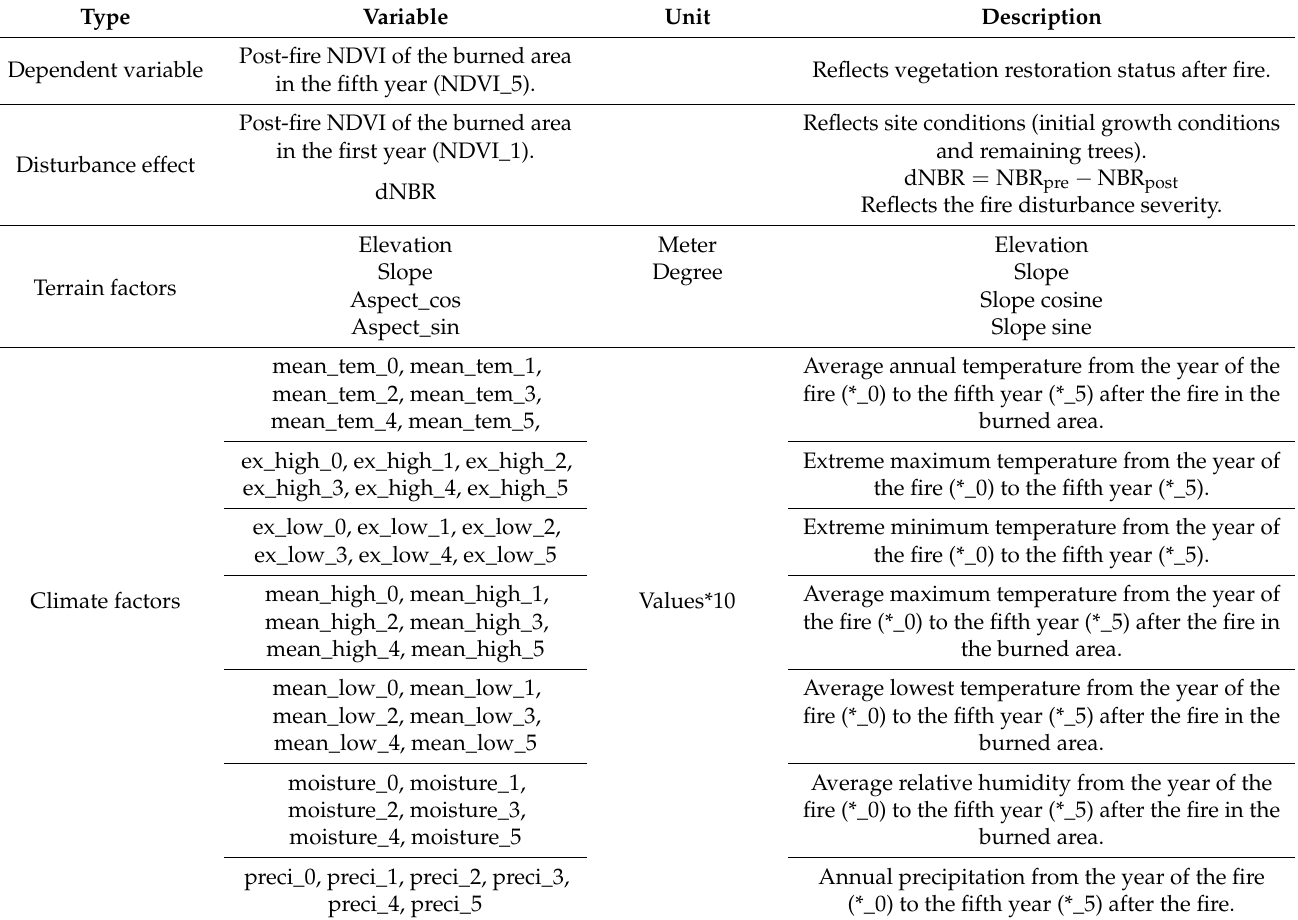
Table 2. Description of the variables used in vegetation recovery